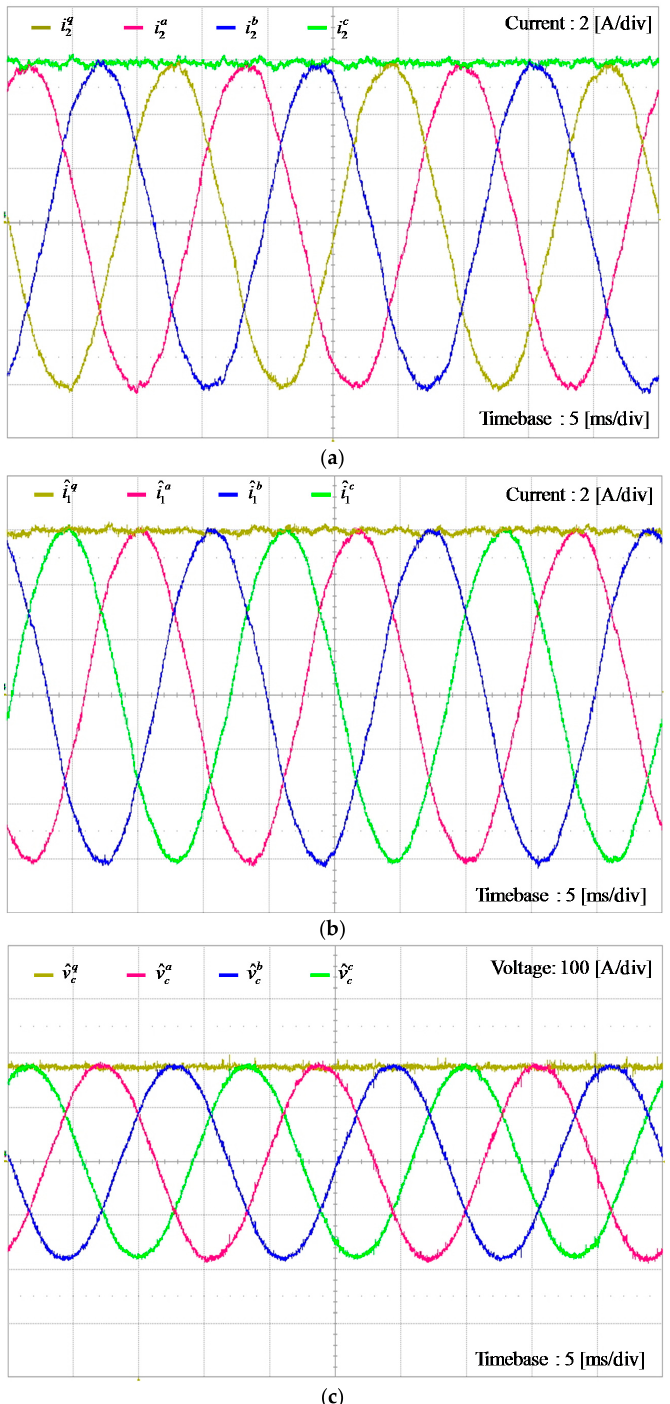
Figure 11. Experimental results for the proposed discrete-time integral state feedback control scheme with state observer. ( a ) Grid-side currents; ( b ) Estimated inverter-side currents; ( c ) Estimated capacitor voltages.